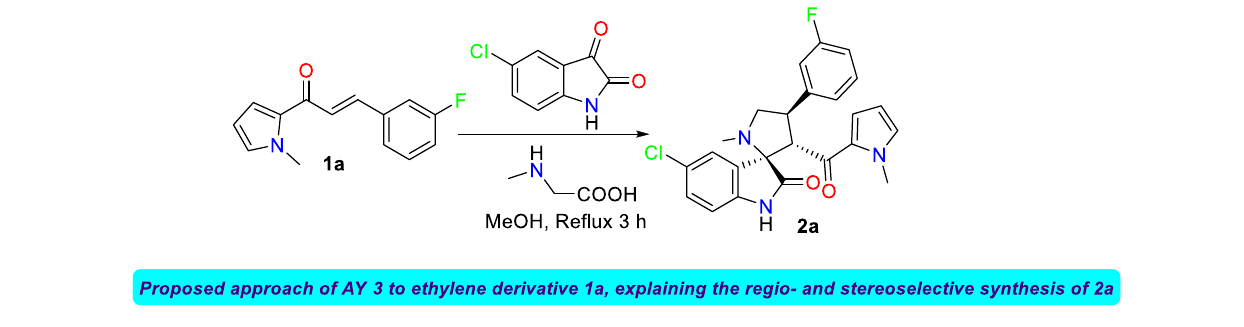
SCHEME 2 | Synthesis and plausible mechanism for the desired spirooxindole derivative 2a